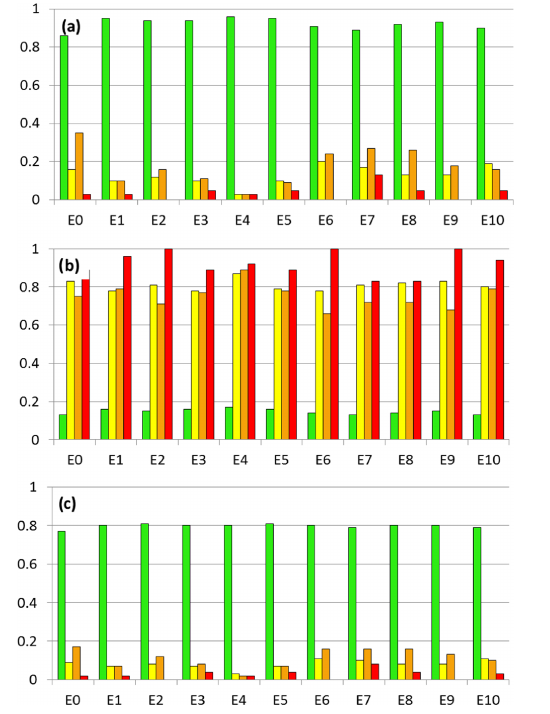
Figure 5. POD (a) , FAR (b) and CSI (c) indexes values for 4- category contingency tables for each configuration. Bar colours are related with Euskalmet warning system thresholds.